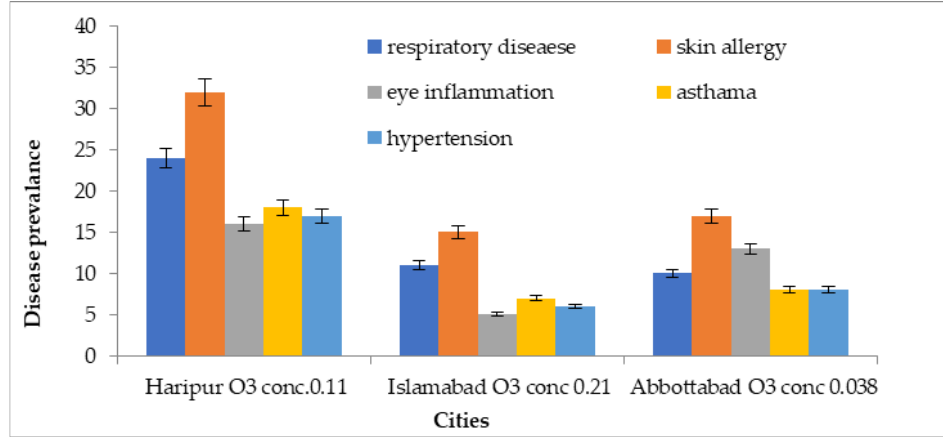
Figure 14. Disease prevalence associated with ozone exposure in 3 megacities of Pakistan .